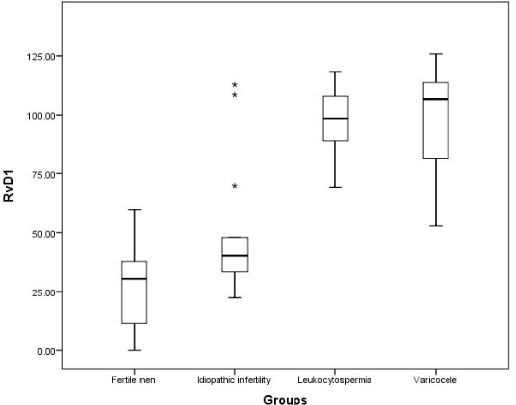
Figure 4. Resolvin levels in the four examined groups. Values are expressed as median and interquartile ranges (IQR). The symbols on top are the outliers. were considered using the Spearman’s Rank Correlation Coefficient. In fertile men RvD1 negatively correlated with sperm morphology ( − 0.521, p < 0.05) and F 2 -IsoPs positively with sperm immaturity (0.583, p < 0.05). In varicocele infertile patients RvD1 negatively correlated with sperm motility (0.465, p < 0.05) and in leukocytospermia positively with sperm necrosis (0.453, p <